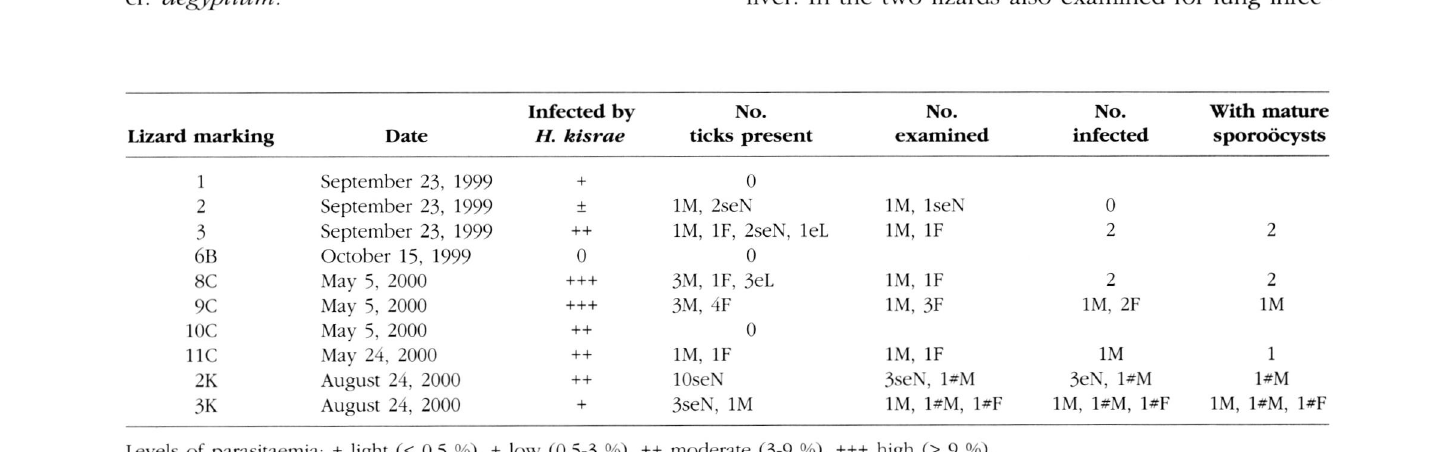
Table 11. - Analysis of the state of infection of starred lizards and ticks collected in Kisra olive grove (site a); ticks: M-male, F-female, N- nymph, L-larva, e-engorged, se-semiengorged. * Immature ticks were allowed to molt before examination.